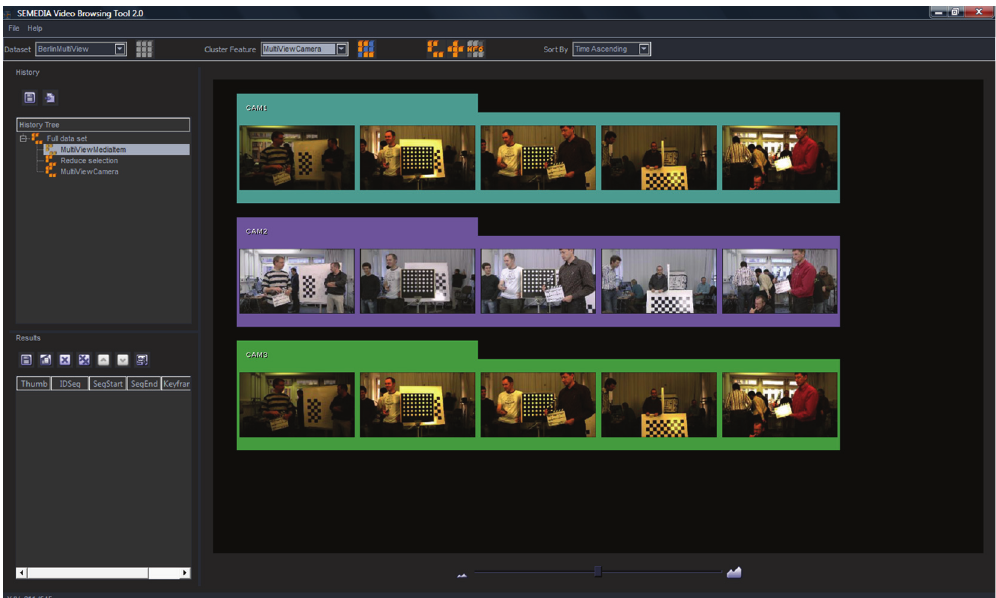
Figure 7: Screenshot of the video browsing tool: multi-view